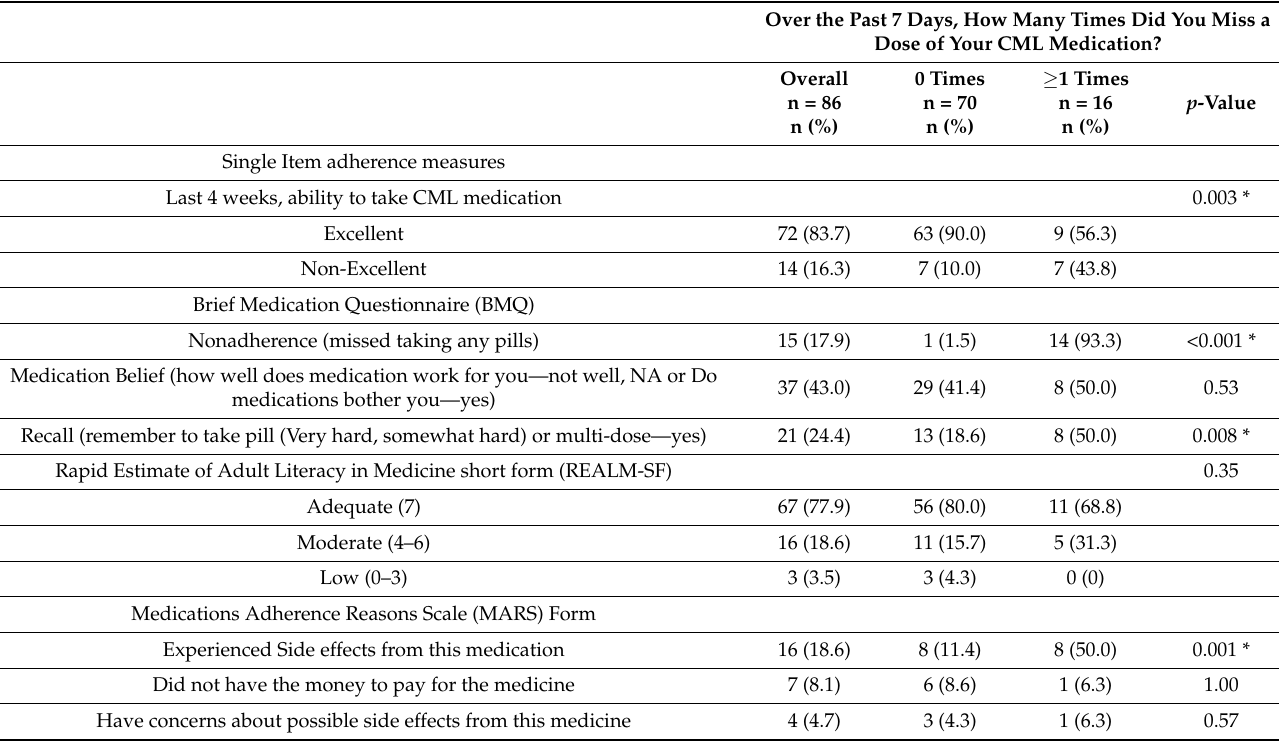
Table 2. Medication Adherence Single Item Questions: past 7 days among patients with chronic myelogenous leukemia (CML) who were prescribed oral